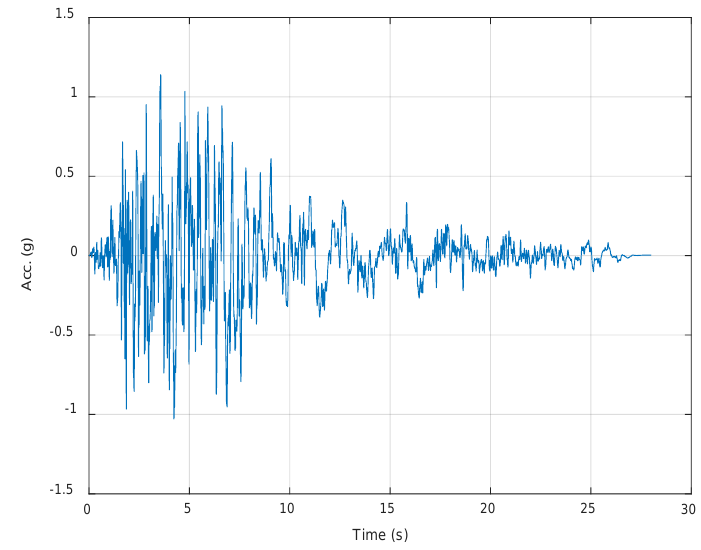
Figure 7. Input ground motion (EQ #1, PGA = 1 g).